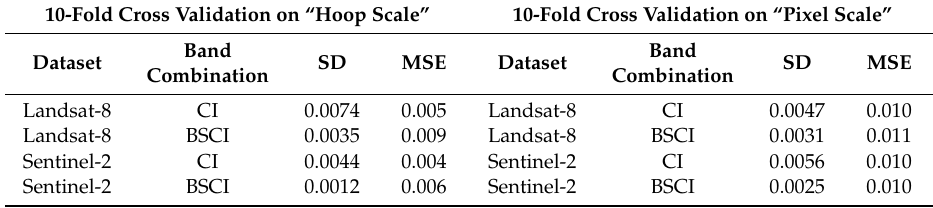
Table 3. Standard deviation (SD) and Mean Square Error (MSE) in each fold validation of 10-fold cross